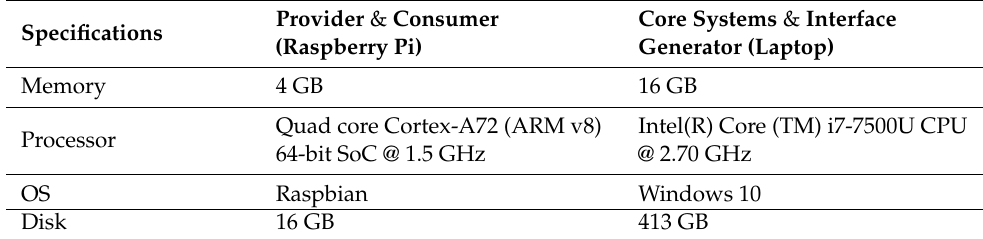
Table 3. Testbed setup specifications.